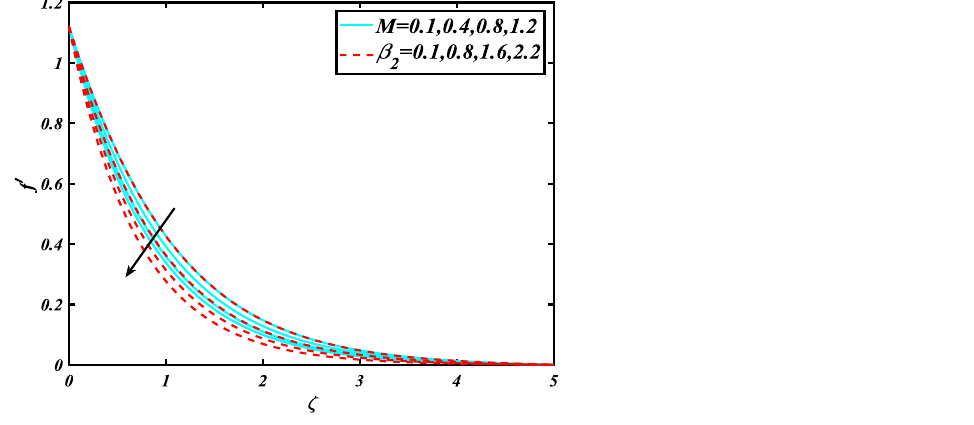
Figure 3. Significance of M & β 2 for f ′ .